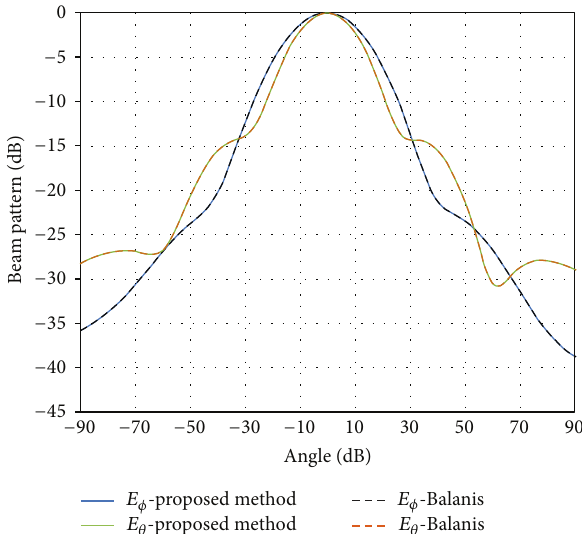
Figure 17: Near field radiation pattern of conical horn at 𝑟 = 𝐷 2 /𝜆